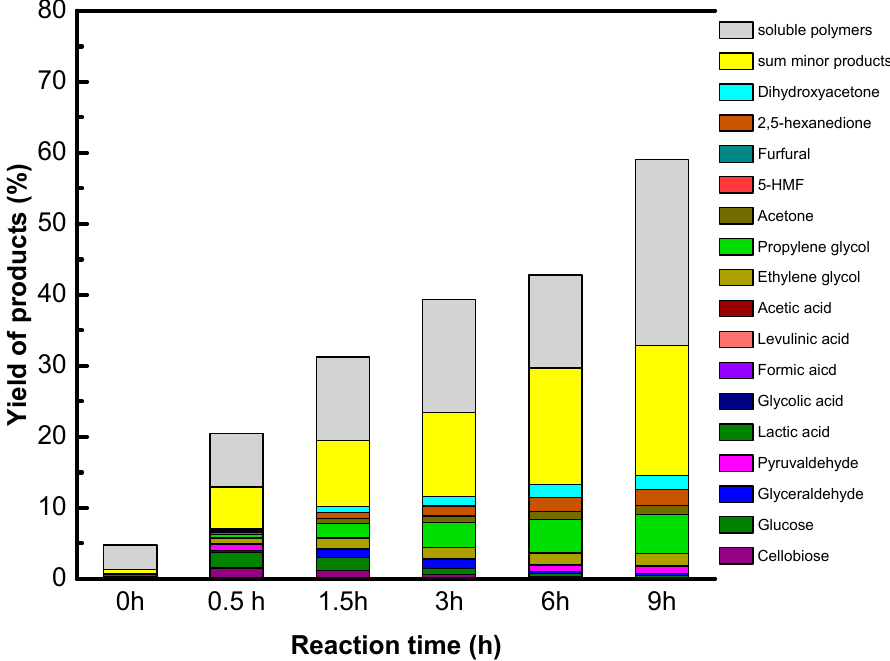
Figure 7. Kinetic of cellulose hydrolysis-hydrogenation in liquid products catalyzed by a mixture of 1%Pt/reGO and GO (1/1) under hydrogen atmosphere. Reaction conditions: T = 190 °C, p H 2 = 50 bar, m catalyst = 0.68 g, m cellulose = 1.6 g, and m water = 65 g.